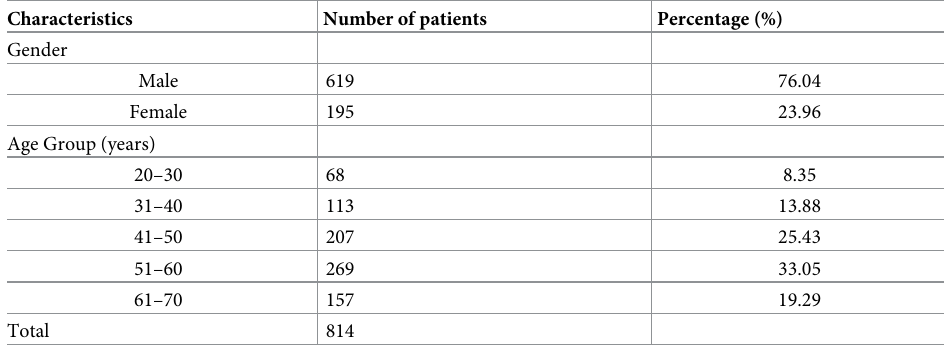
Table 1. Gender and age distribution of the